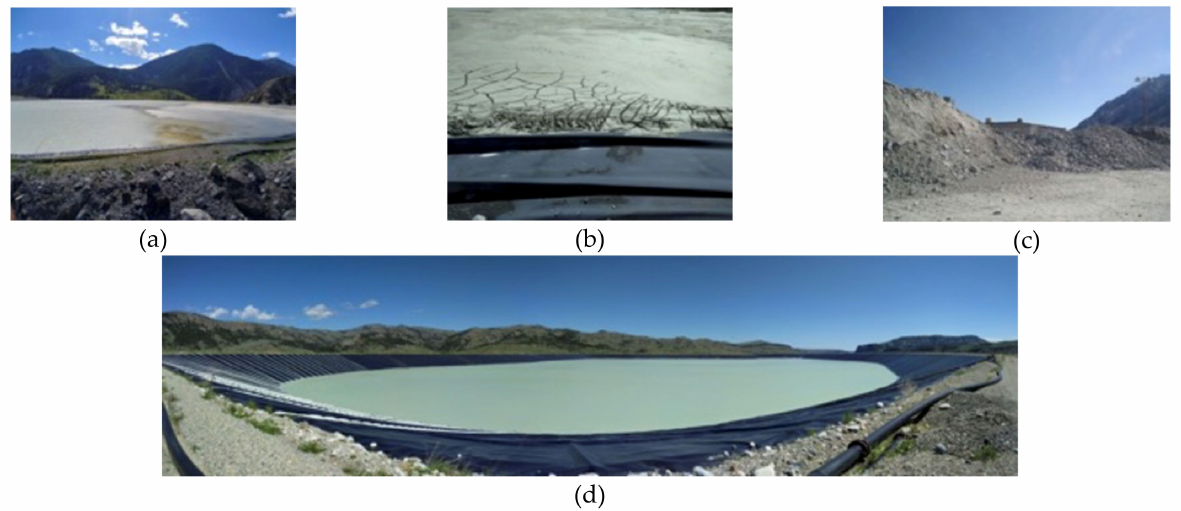
Figure 1. Photos of tailings storage facilities at the Stillwater mine, photographed by Noah McQueen in 2019: ( a ) Pond 1, idled; ( b ) closer photo of Pond 1, showing signs of crust at the pond surface; ( c ) waste rock pile; and ( d ) Pond 2, which has a large remaining capacity for additional